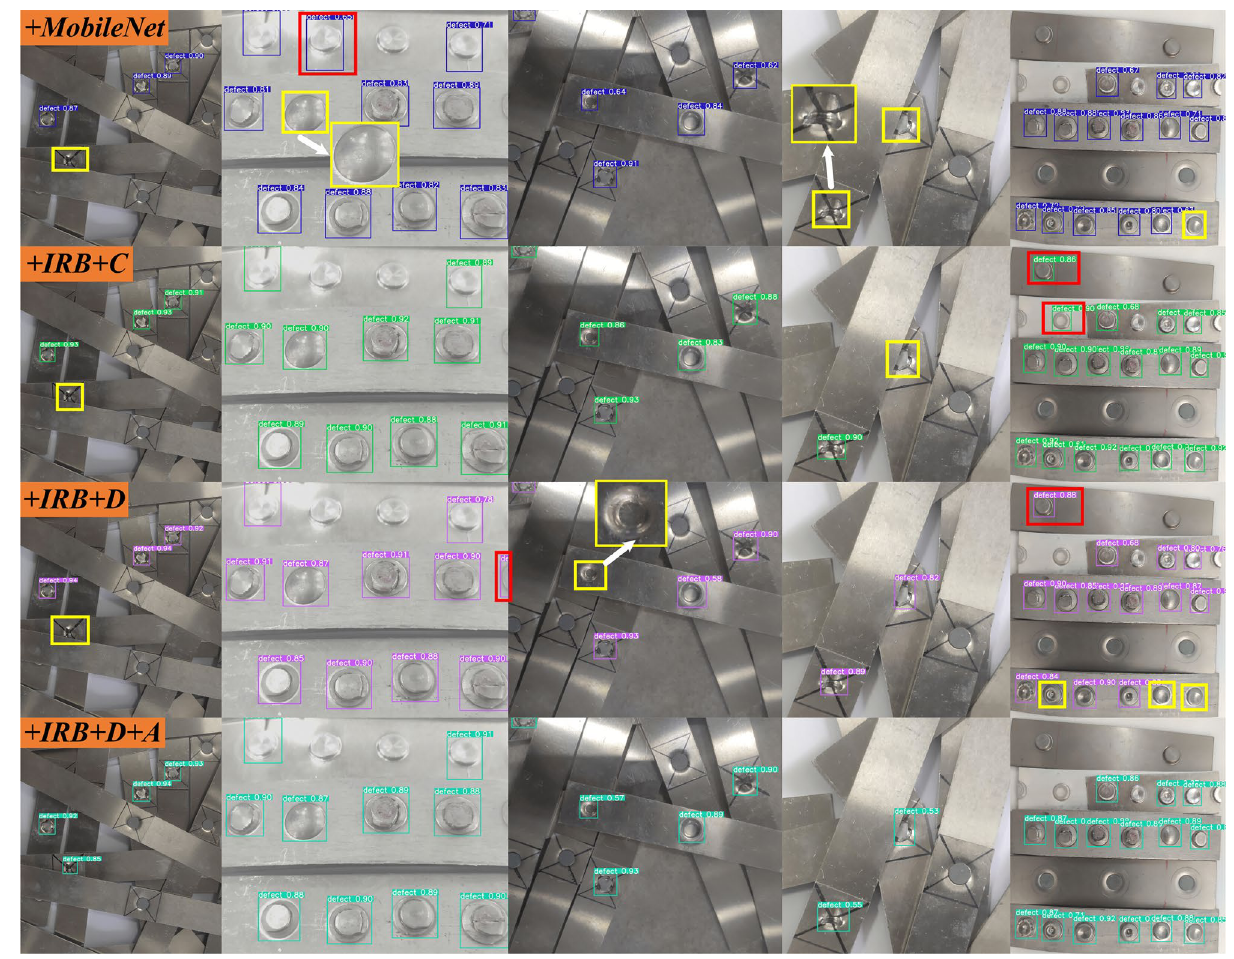
Figure 14. Qualitative comparison results of different improved methods, each row represents the detection result of one algorithm. Missed and incorrectly detected targets are marked with yellow and red rectangles,